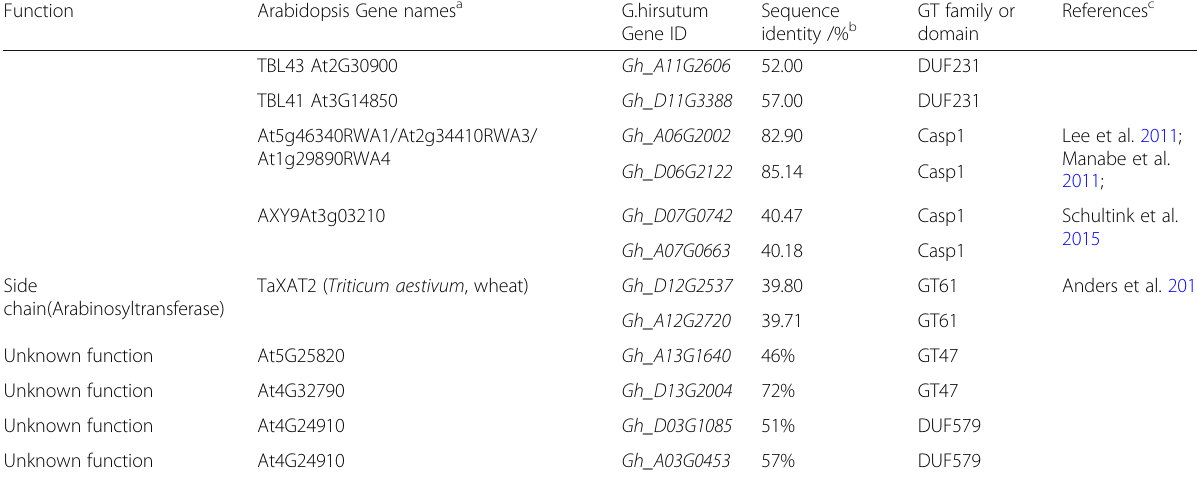
Table 1 Fifty-five candidates involved in fiber xylan synthesis in upland cotton